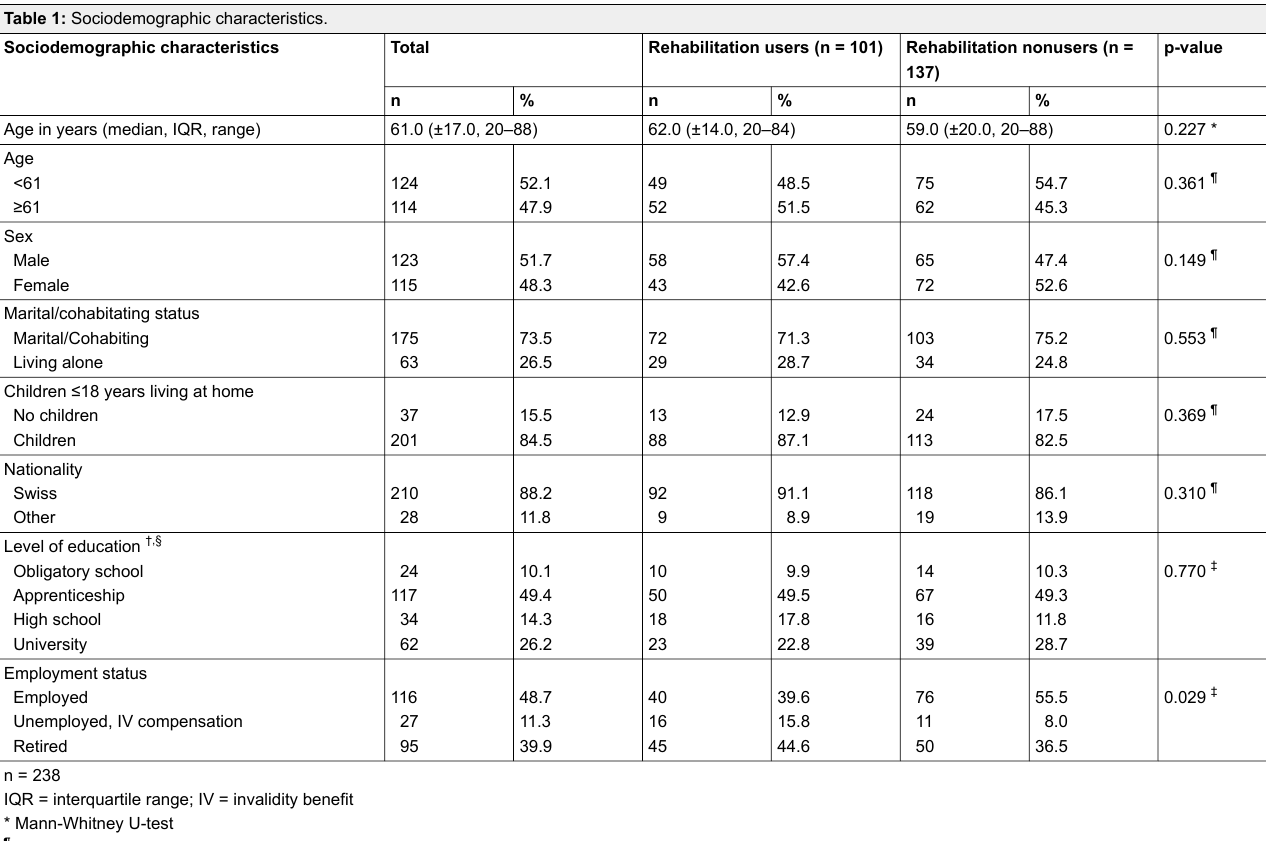
Table 1: Sociodemographic